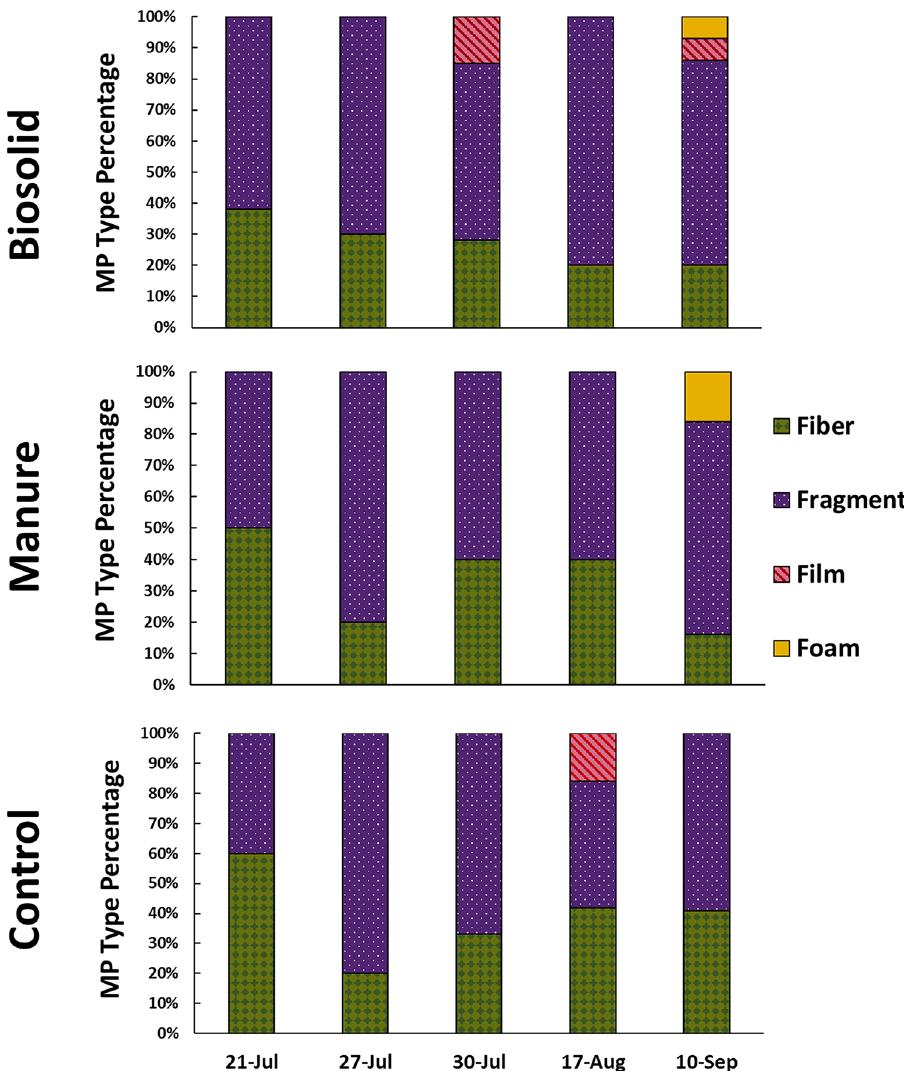
Fig. 3 Distribution of detected MPs based on their shape in all the runoff samples. Each panel represents the distribution of MPs in runoff from biosolid, manure, and control plot in all the sampling events. Fibers are shown in green (solid diamond grid pattern), fragments in purple (dotted pattern), fi lms in red (diagonal strips), and foams in yellow (without